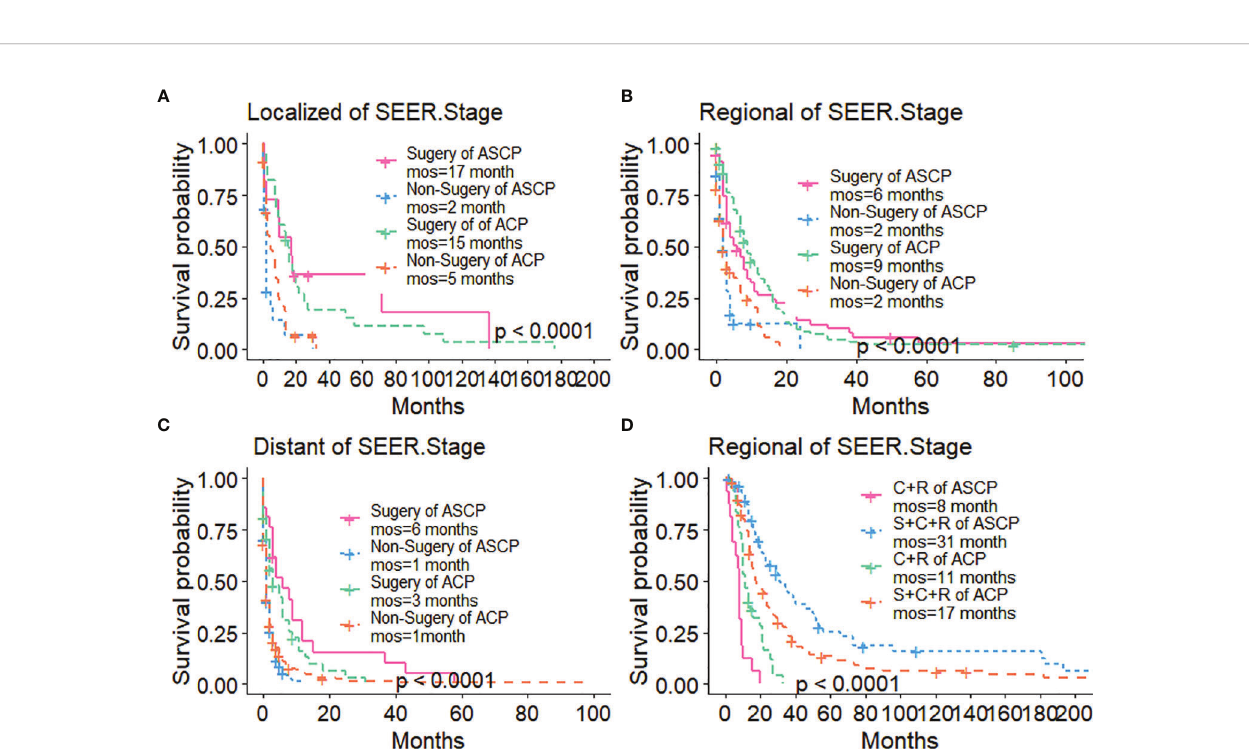
FIGURE 4 | Survival Curves of ACP and ASCP: (A) Surgical Treatment in Localized Stage; (B) Surgical Treatment in Regional Stage; (C) Surgical Treatment in Distant Stage; (D) Comparison of Treatment Methods in Regional Stage (S, surgery; C, chemotherapy; R,